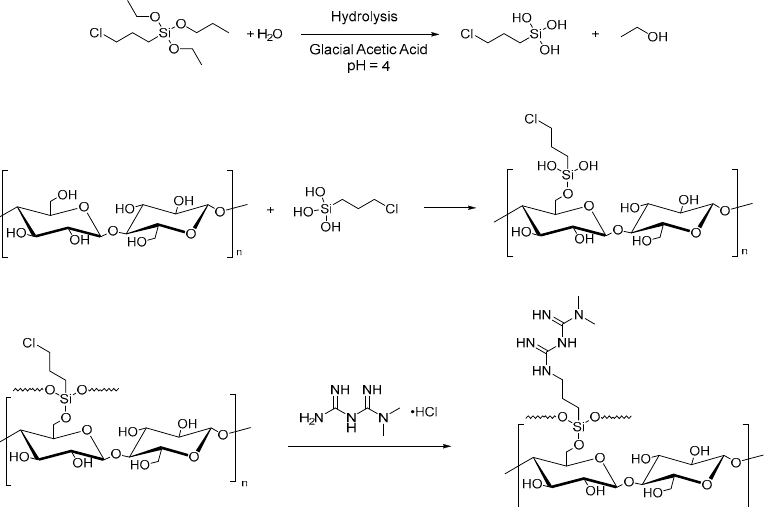
Figure 6. Silylation of MCC with CPTES and amine-functionalization (1,1-dimethylbiguanide hydrochloride).